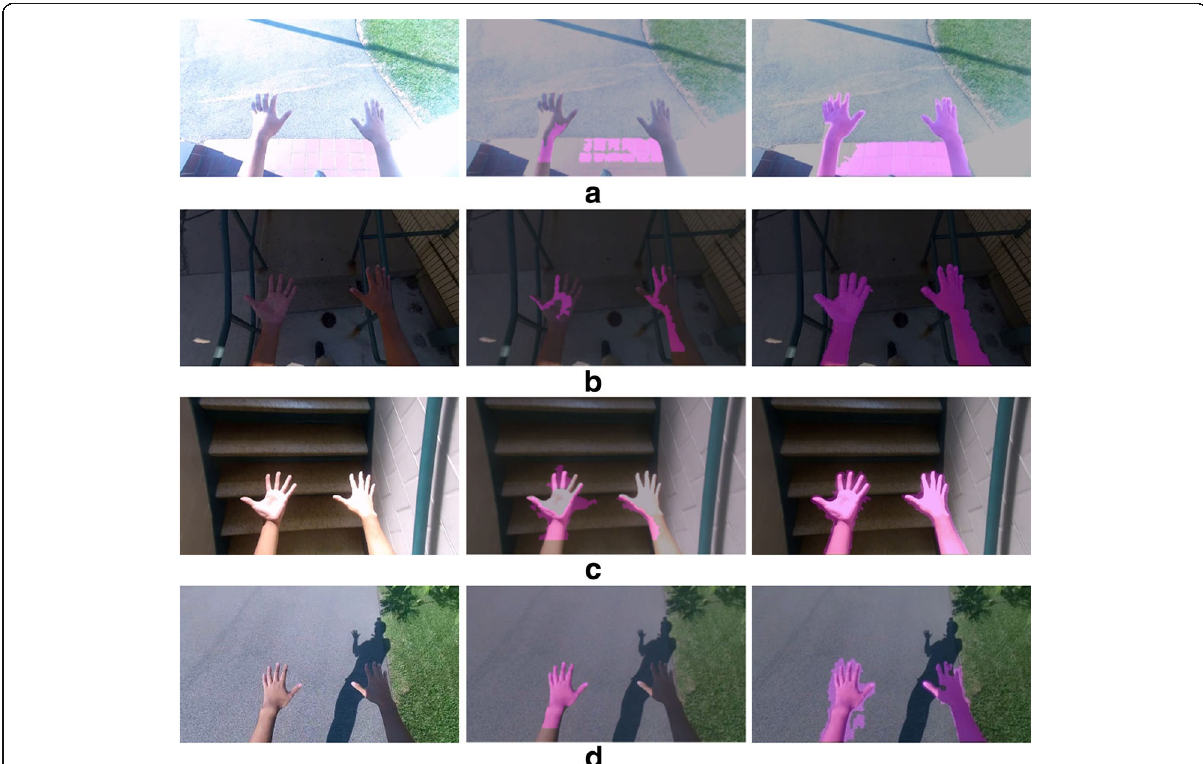
Fig. 6 a – d Challenge illumination cases comparison. From top to bottom are cases of overexposed, underexposed, overexposed, and high contrast shadows. The first column shows the original images. The middle column shows results of Li and Kitani [1] and the last column shows our